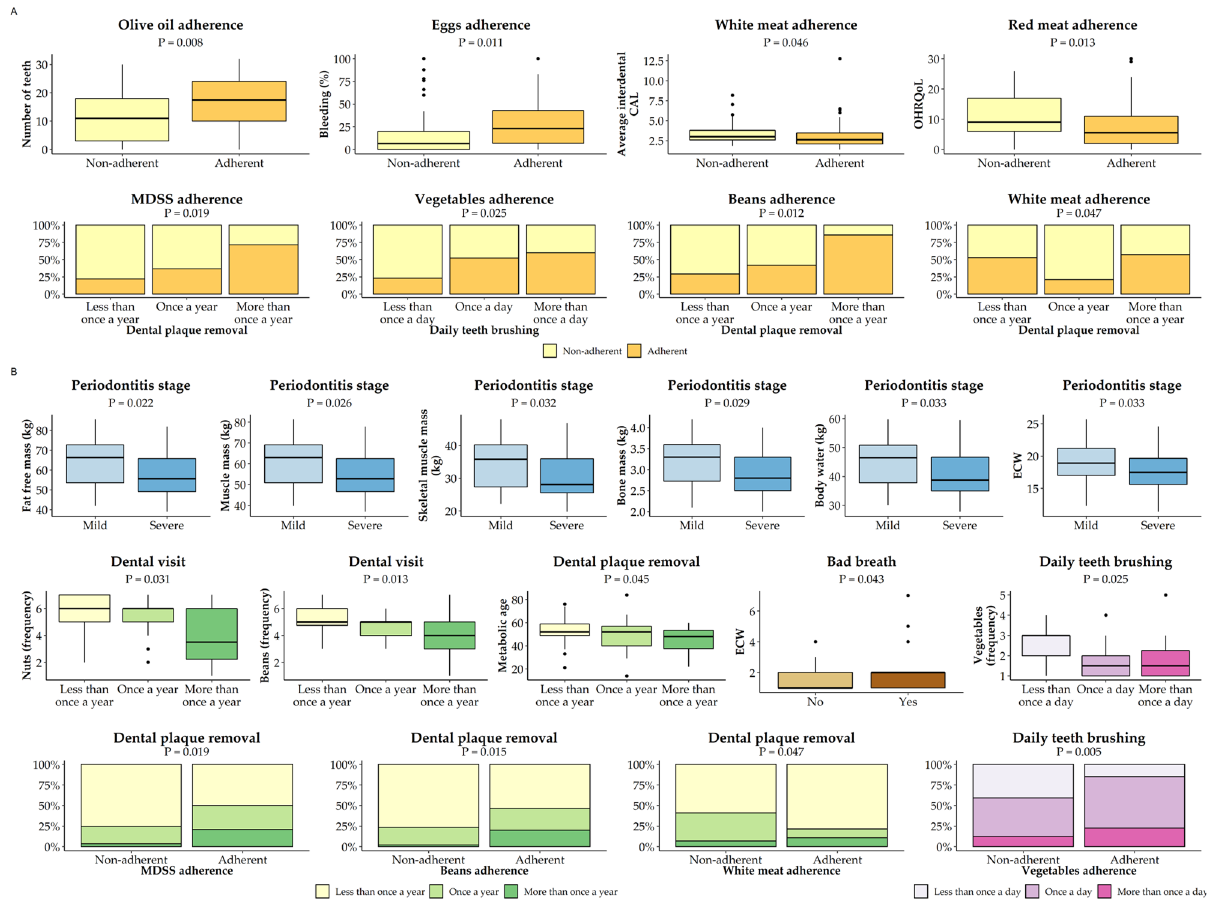
Figure 2. Significant associations between dental, MeDi and body composition parameters based on descriptive statistics. ( A ) Categories based on adherence to MeDi and its components; ( B ) categories based on categorical dental parameters. ECW extracellular water, MDSS Mediterranean Diet Serving Score, CAL clinical attachment loss; OHRQoL Oral Health Related Quality of Life. Color coding according to the categories of specific parameters: orange—adherence vs non-adherence to MeDi and its components; blue—mild vs severe periodontitis stage; green—yearly dental visit or dental plaque removal; purple—daily teeth brushing; brown— presence vs no bad breath. MeDi components depicted as frequency ranges from 1 to 7; 1—two or more times a day, 7—rarely or